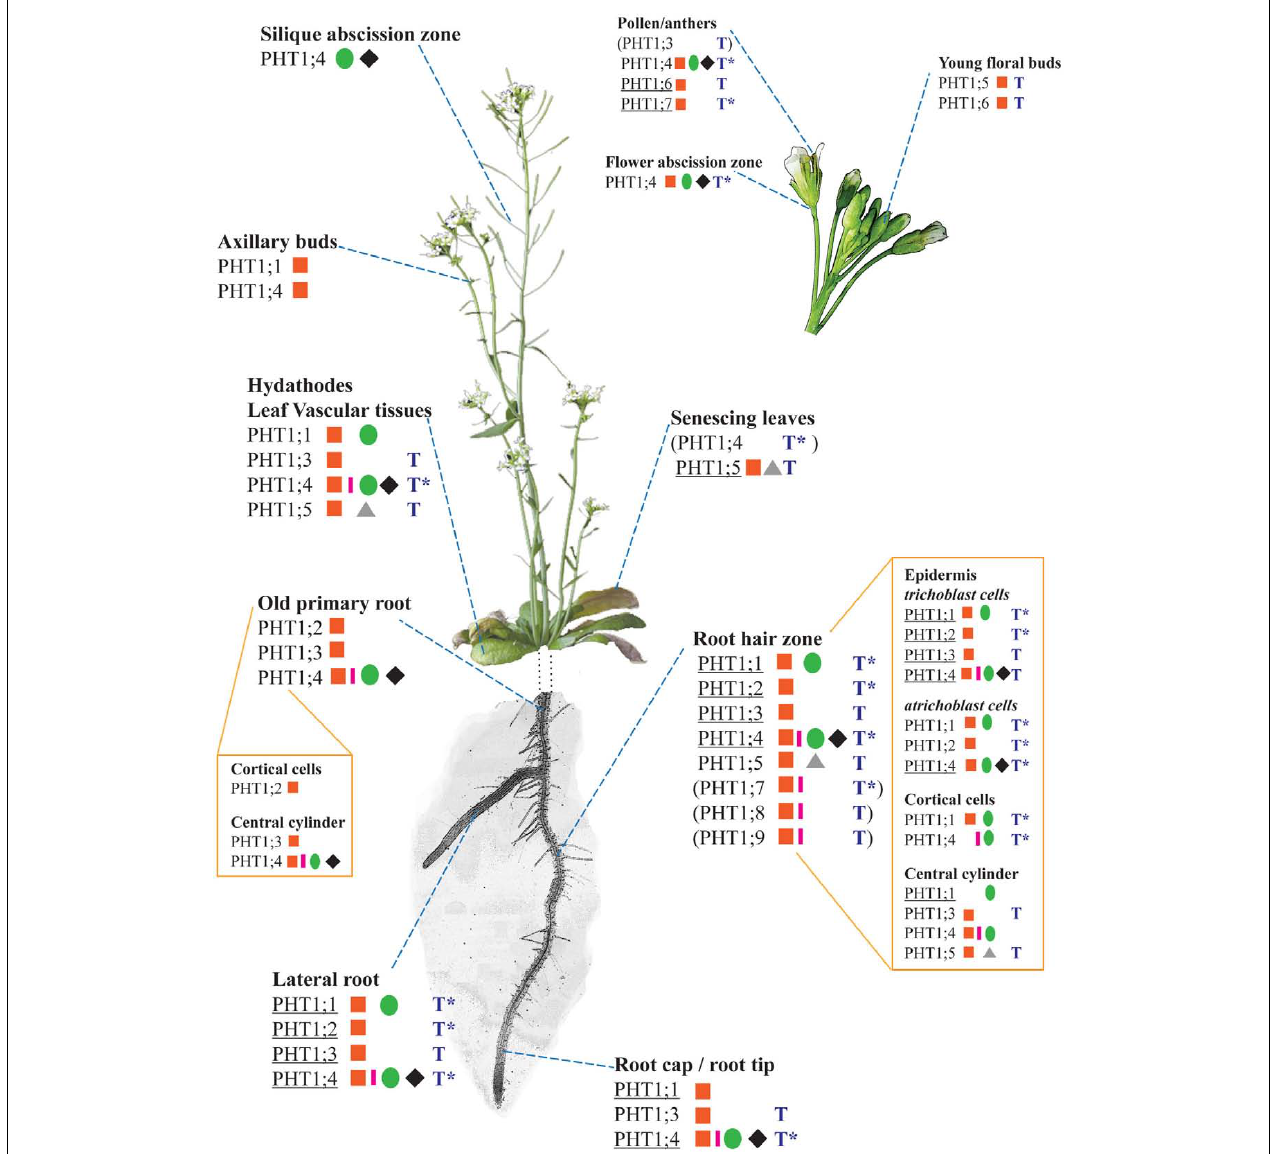
(Karthikeyan et al., 2009), and gray triangle (Nagarajan et al., 2011). Results based on transcriptomics studies are indicated by a blueT, and they correspond to a summary of several data sets presented on the eFP server (Winter et al., 2007). ∗ Due to the design of most transcriptomic chips, it is not possible to distinguish the expression patterns of PHT1;1/PHT1;2 as well as PHT1;4/PHT1;7.When a PHT1 transporter is predominantly (but not exclusively) expressed in one or several tissues, its name is underlined.The subset of expression data indicated between brackets () are based on RT-PCR and/or transcriptomics only (i.e., not validated by promoter::reporter